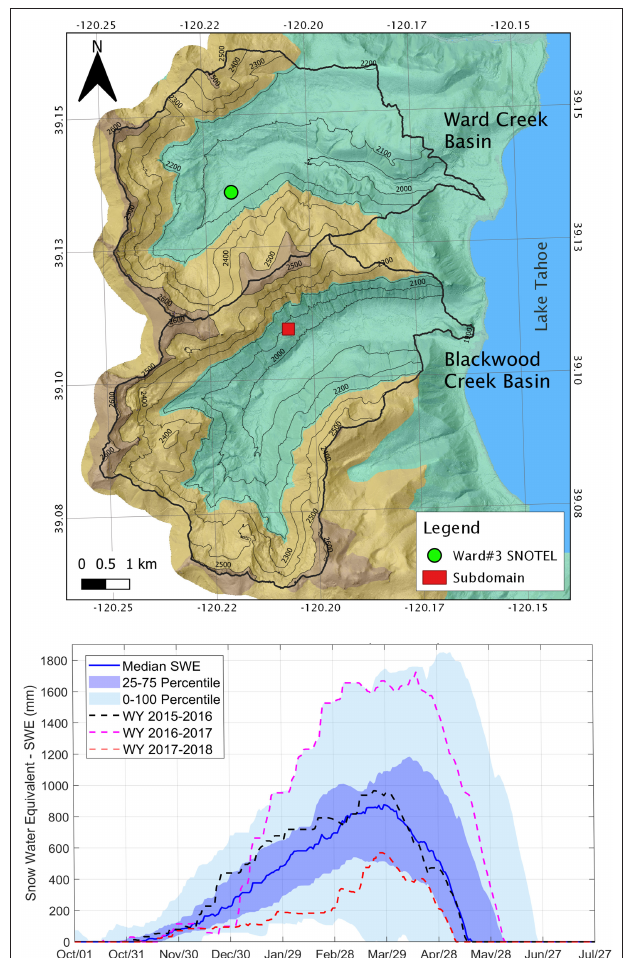
FIGURE 1 | Upper panel: Relief map showing the modeled basins along the west shore of Lake Tahoe, California (contour interval = 100m). The red rectangle shows the subdomain (150 × 150m) presented in Figure 4 . Lower panel: Observed snow water equivalent (SWE) climatology at the Ward #3 SNOTEL station, including the observed SWE for the three water years simulated in this study (dashed